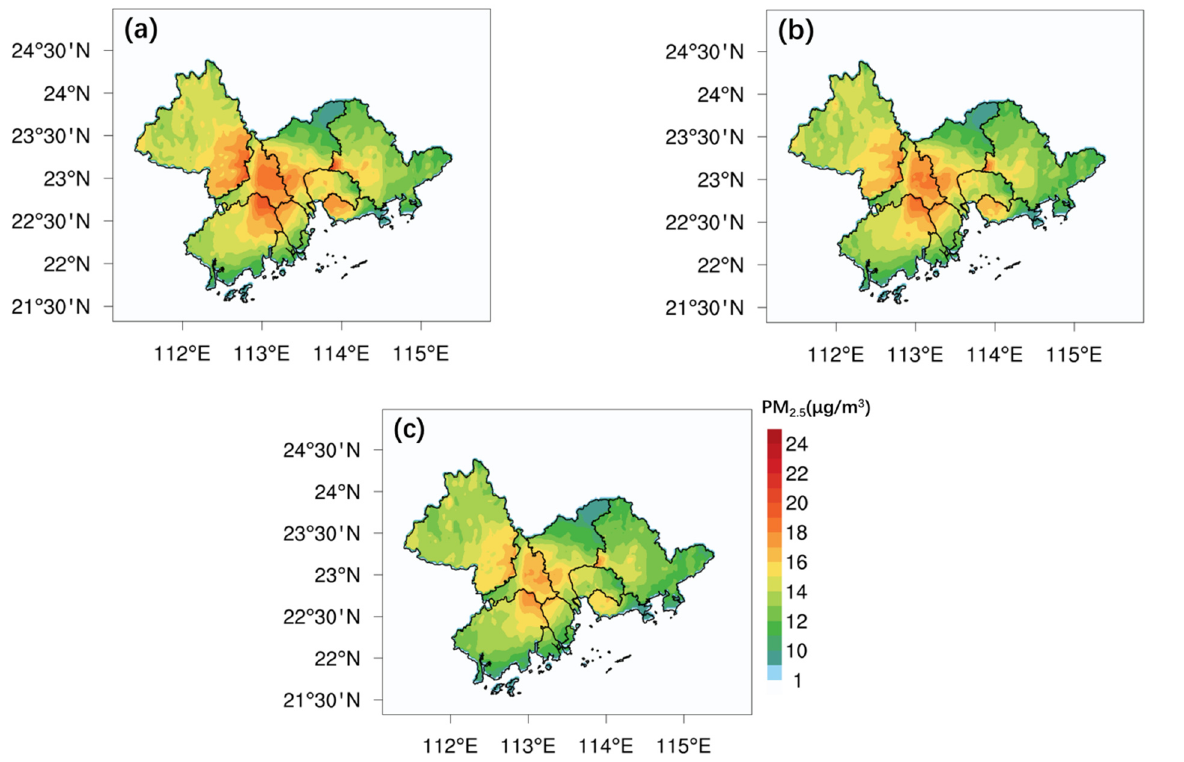
Figure 7. Air quality levels under three scenarios in 2035: ( a ) BAU, ( b ) MAS, ( c ) EAS.